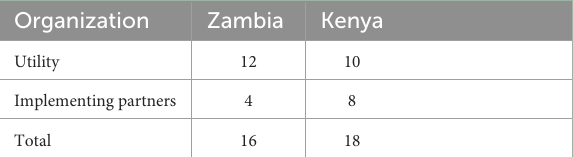
TABLE 1 Summary of